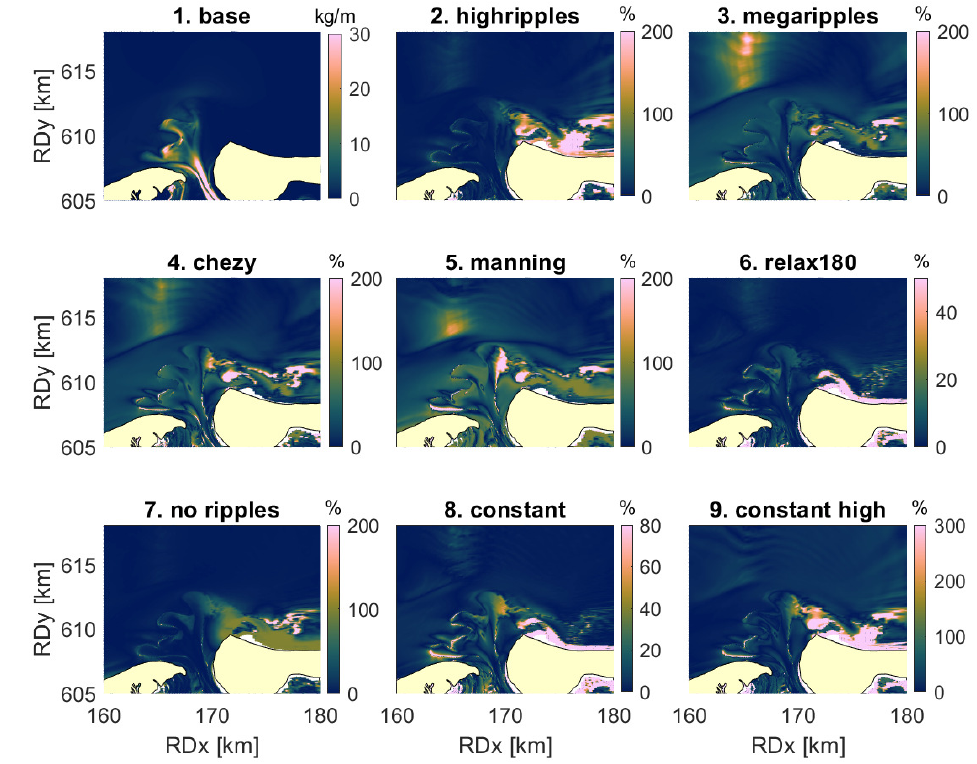
Figure 10. Time-integrated suspended load transport q s during calm weather (1), and absolute relative difference in q s of all other scenarios with the base scenario during calm weather